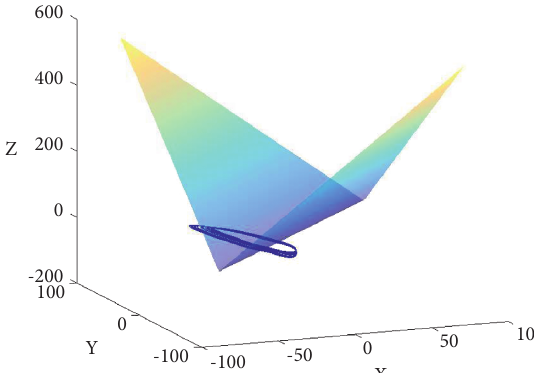
Figure 2: The piecewise linear function of the proposed system when a � 3 . 5 and b � 1 in xyz view. Also, the attractor of the system is plotted in dark